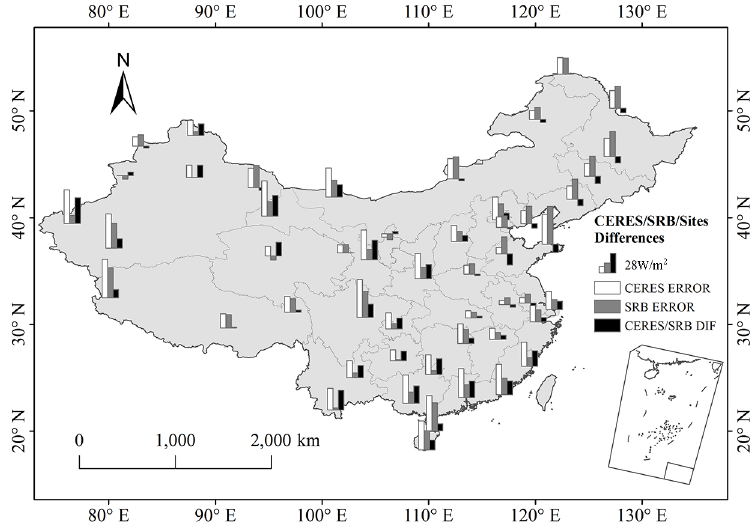
Figure 3. Error distribution of monthly surface net radiation generated from the CERES and SRB data for the period from March 2000 to December